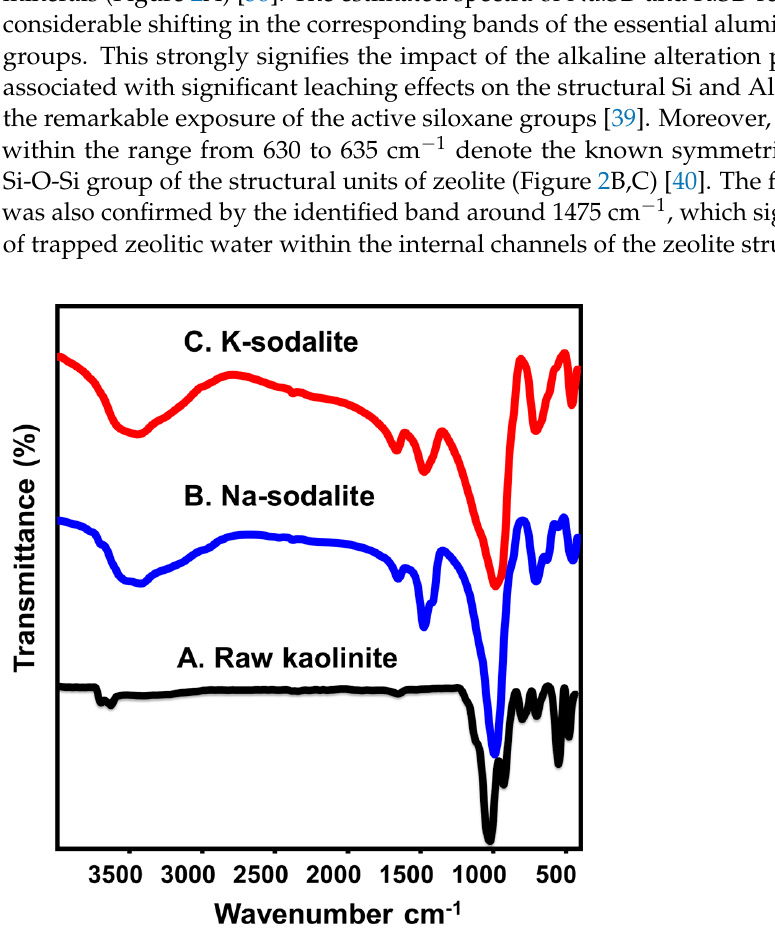
Table 1. The textural properties of kaolinite, K.SD, and Na.SD.